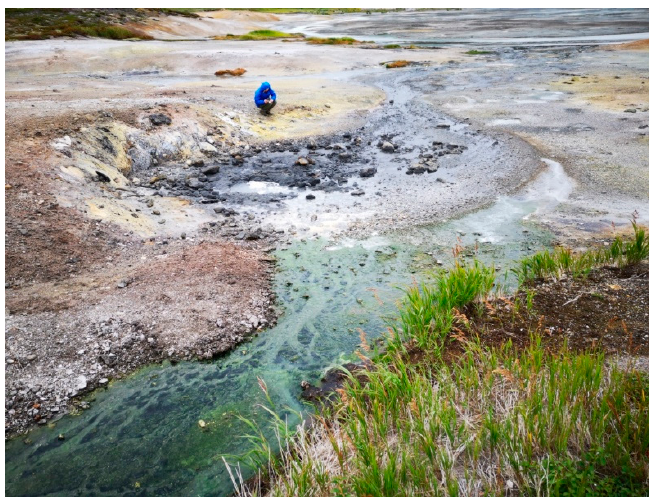
Figure A5. Shaman geyser conduit top view, grid scale 20 cm. Photo by A. Kiryukhin, 24 August 2019.